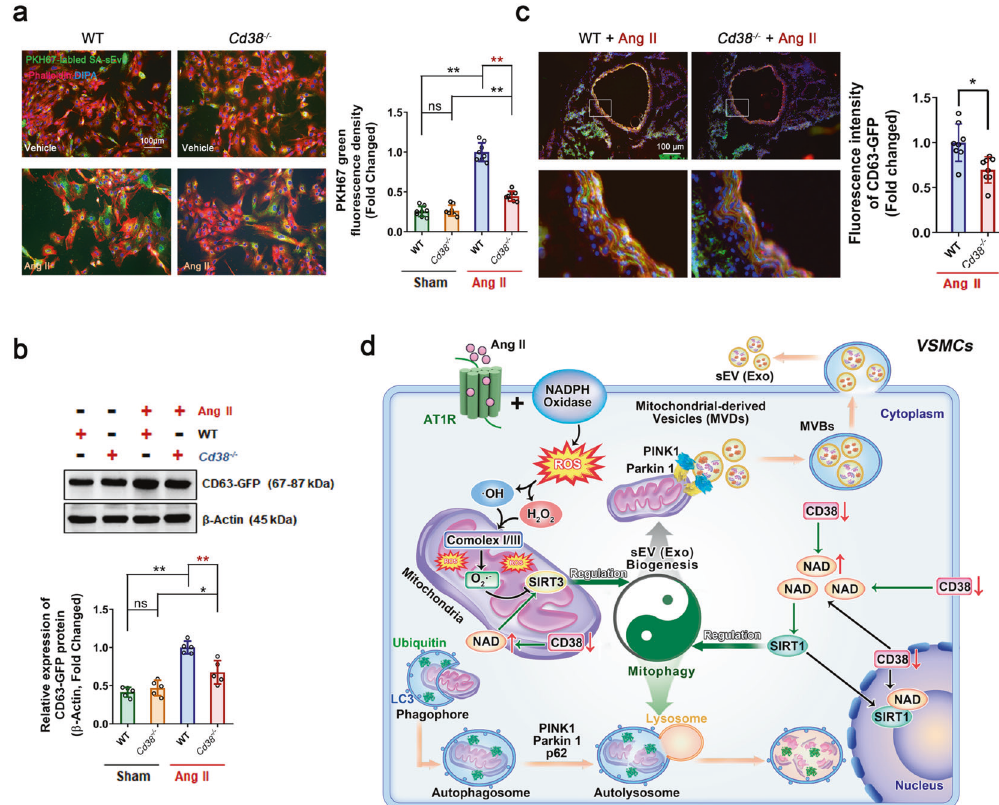
Fig. 8 CD38 de fi ciency prevented the uptake of SA-sEVs by VSMCs after Ang II challenge. a , b In vitro sEV internalization was analyzed in VSMCs with Ang II or Vehicle stimulation. (a) Internalized SA-sEVs were detected by cellular micro fl uorescence imaging in VSMCs treated overnight with PKH-67 fl uorescent dye-labeled SA-sEVs derived from senescent VSMCs (green dots represent sEVs, n ≥ 5, one-way ANOVA, * p < 0.05, ** p < 0.01). (b) GFP protein expression in VSMCs treated overnight with SA-sEVs derived from CD63-GFP VSMCs was detected by western blot analysis. GFP protein expression represented the quantity of SA-sEV uptake by VSMCs ( n ≥ 5, one-way ANOVA, * p < 0.05, ** p < 0.01). c Ex vivo internalization was analyzed in vessels of WT and Cd38 − / − mice stimulated with Ang II. SA-sEVs, including CD63-GFP + exosomes, were puri fi ed from senescent WT VSMCs. Then, SA-sEVs were incubated with aortas of WT and Cd38 − / − mice pretreated with Ang II (1 μ M) for 24 h. SA-sEV internalization in aortas after overnight incubation was detected by immuno fl uorescent staining ( n = 8, unpaired t